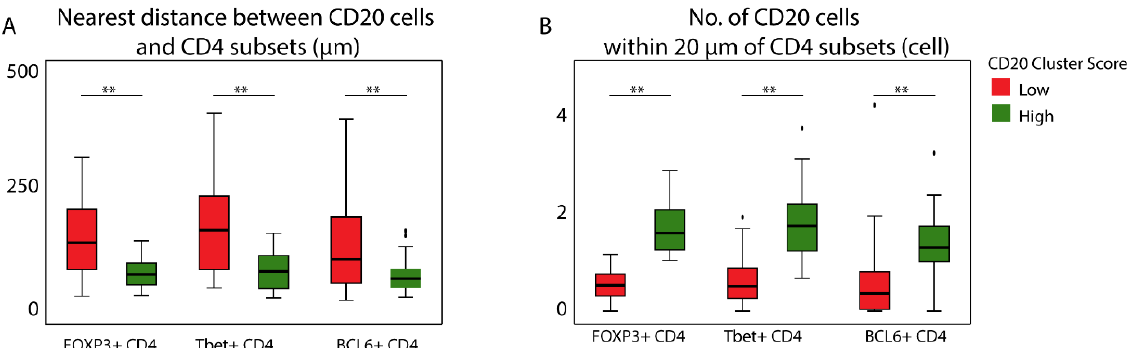
Figure 3. The CD20 cluster score associates with shorter distances between CD20 B cells and CD4 T cell subsets, and higher numbers of CD20 B cells within 20 μ m of CD4 T cell subsets: ( A , B ) Boxplots showing the nearest distance between CD20 and CD4 subsets ( A ), and the number of CD20 B cells within 20 μ m of CD4 T cell subsets ( B ), according to the CD20 cluster score in the IM-S region. Mann–Whitney U test was applied to test for significant differences, ** p < 0.01.